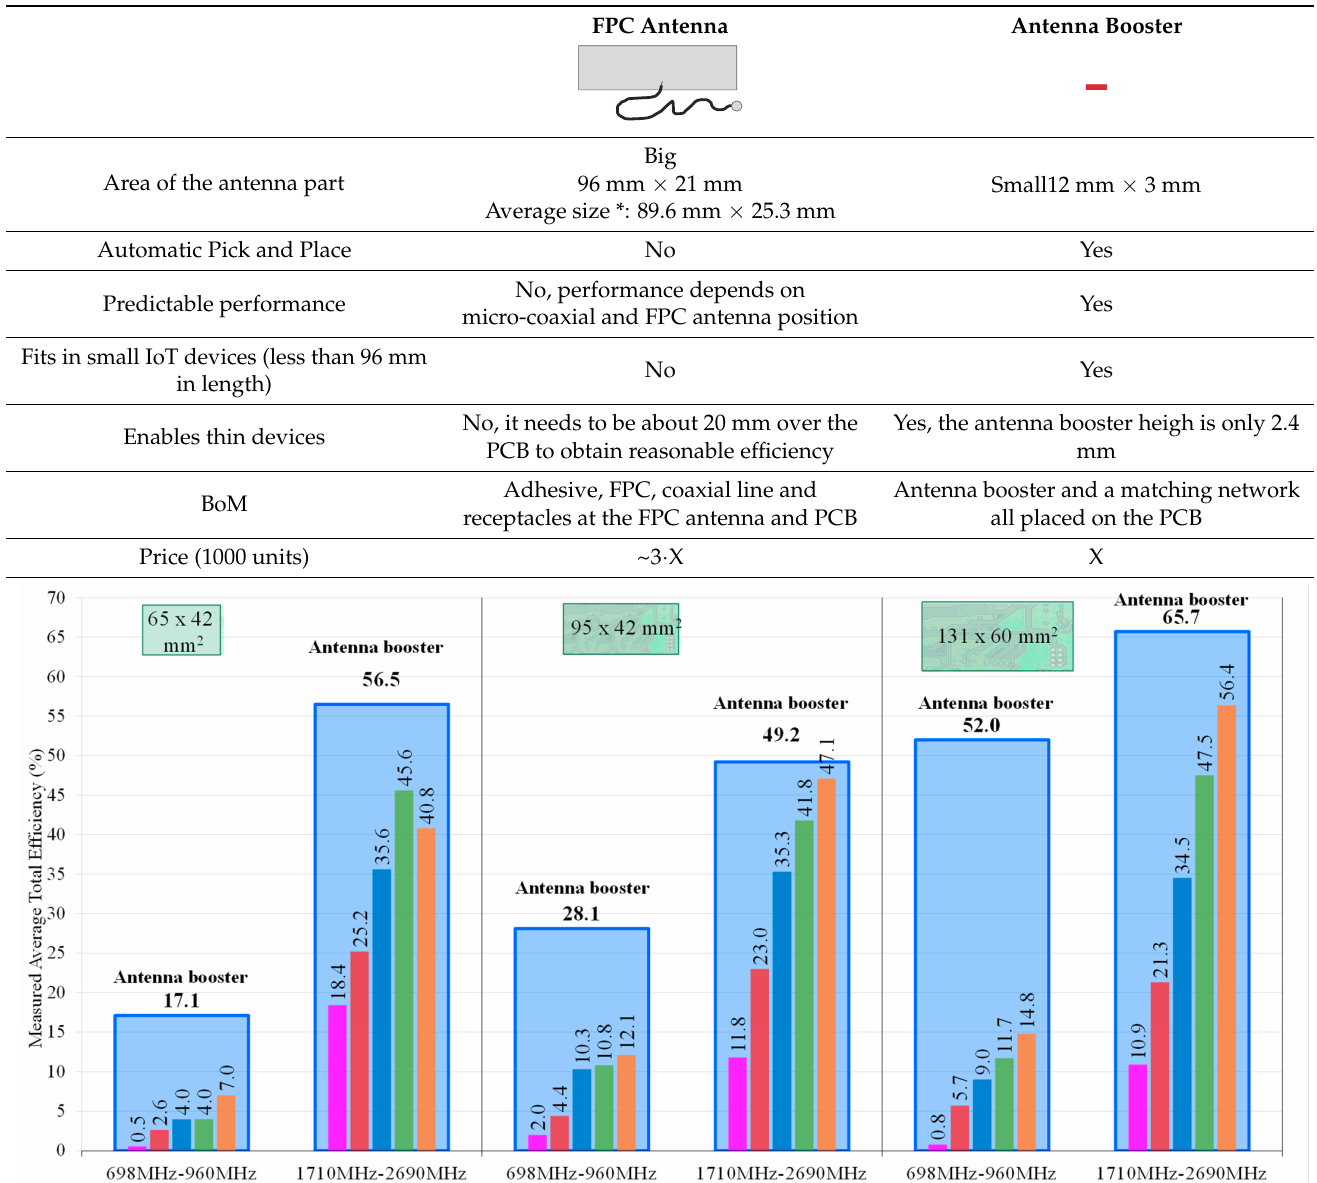
Table 7. Comparison of FPC antennas with Antenna Booster Technology. Schemes of the FPC antenna and antenna booster have the same scale. (*) The average size is obtained from seven antenna samples [24]. X~2.2 € (euro) for 1000 units.